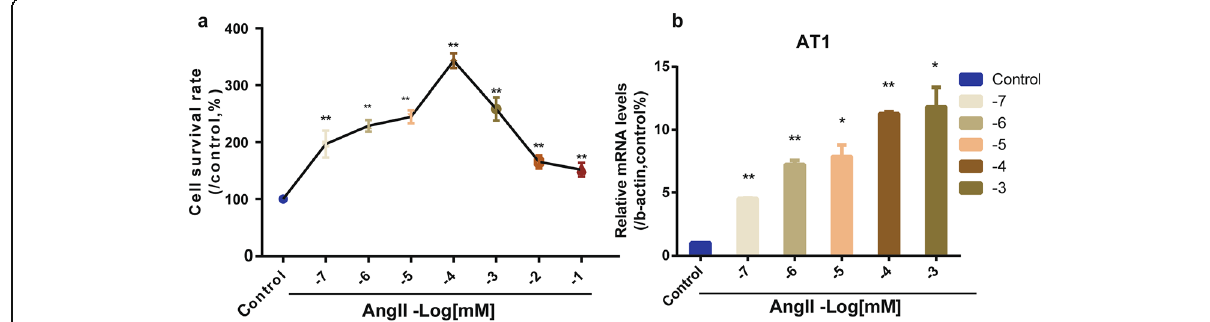
Fig. 5 Effect of Ang II on proliferation of primary vascular smooth muscle cells (VSMCs) in broilers via angiotensin II type 1 receptor (AT1). a Effect of Ang II on the proliferation of primary VSMCs. ( n = 9, ** P < 0.01 vs. control). b mRNA expression of AT1 receptor stimulated by Ang II in primary VMSCs. ( n = 6, ** P < 0.01, * P < 0.05 vs.